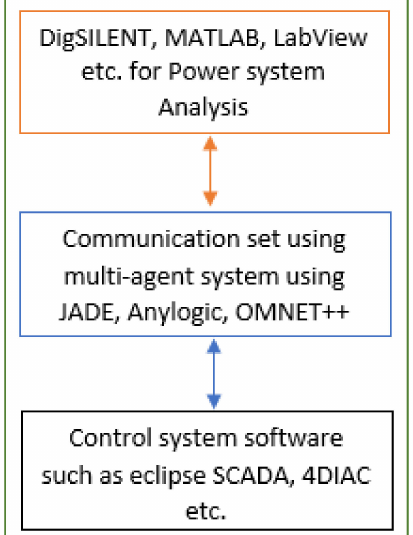
Figure 2. Microgrid communication and control co-simulation approach for communication and control